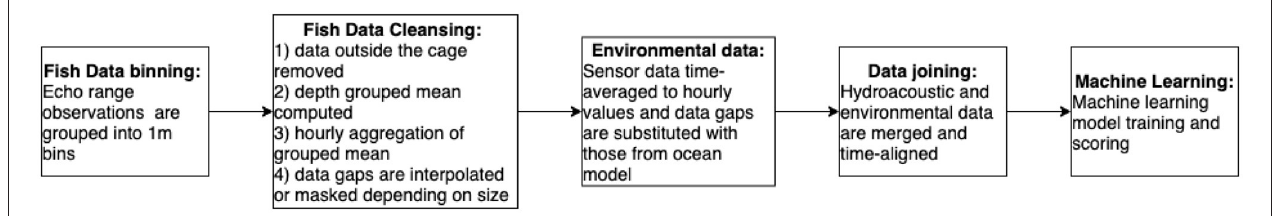
FIGURE 2 | Data processing workflow outlining the main steps of hydroacoustic data binning, data cleansing, environmental data processing, data merging, and finally machine learning model implementation.